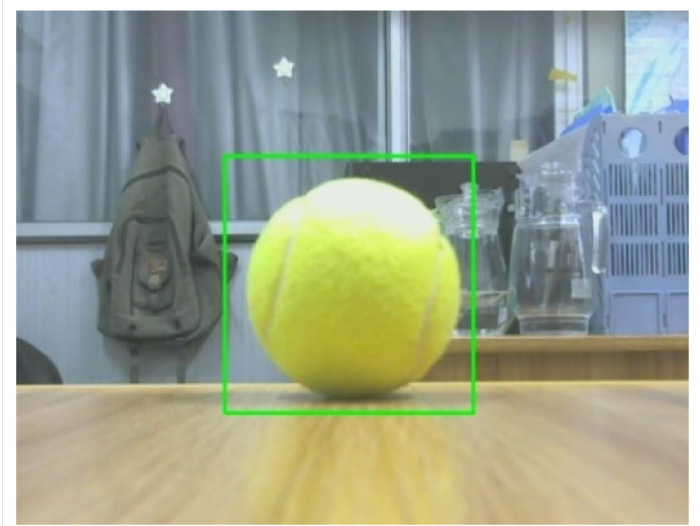
Figure 8. Cascade classifier-based recognition of tennis